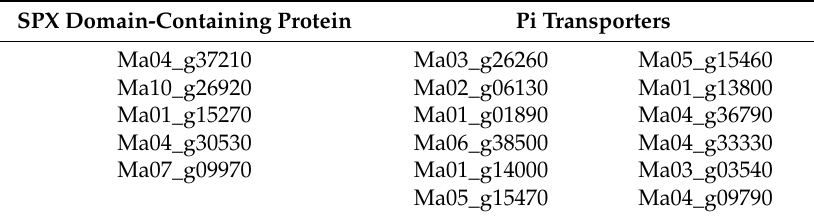
Table 4. Up-regulated genes involved in Pi mobilization under − P treatment. SPX Domain-Containing Protein